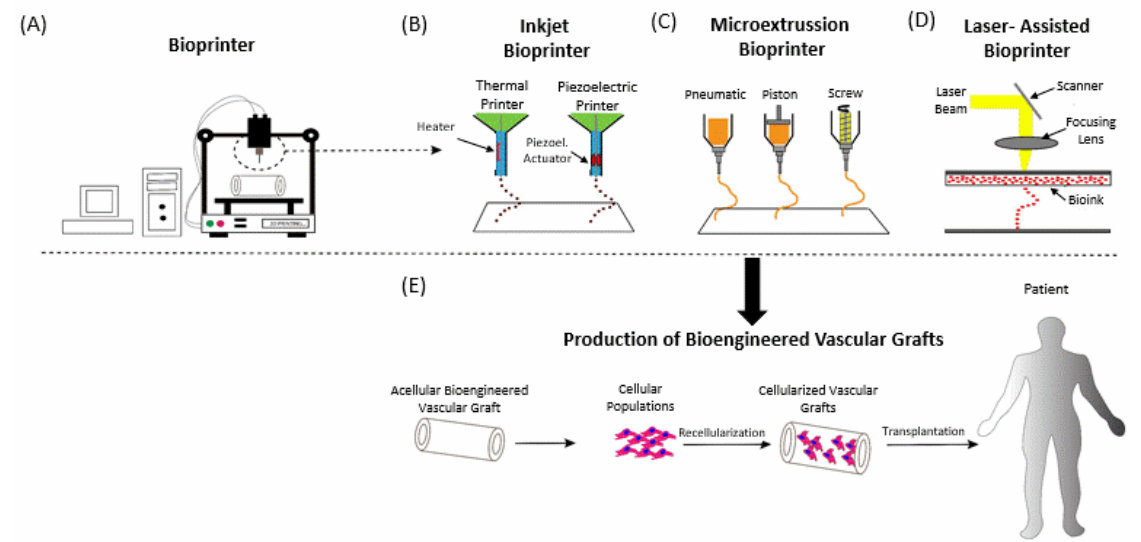
Figure 1. Schematic representation of bioprinters. ( A ) Development of bioengineered vascular grafts with computer assisted software. Different types of bioprinters ( B ), microextrusion bioprinter ( C ) and laser-assisted bioprinter ( D ). ( E ) Production and transplantation of bioengineered vascular grafts. Piezoel: